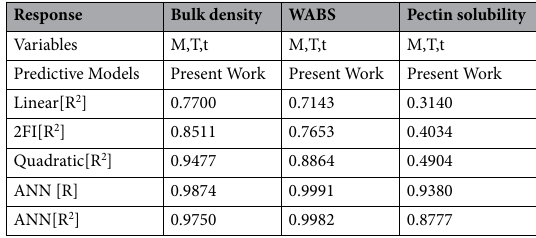
Table 4. R and R 2 values of Conventional and ANN models in the present study. M: Moisture, T: Temperature, t: